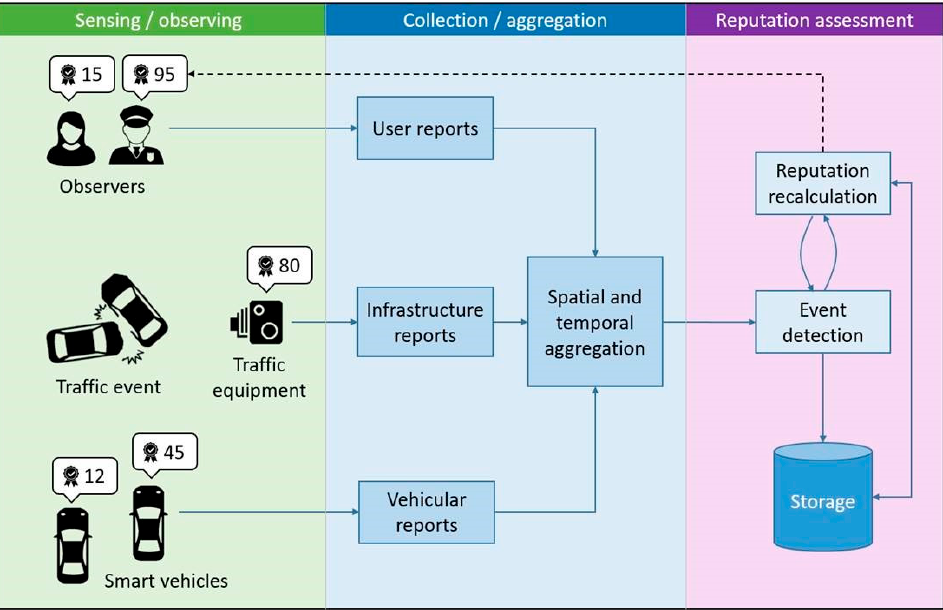
Figure 1. Event detection and source reputation assessment system.